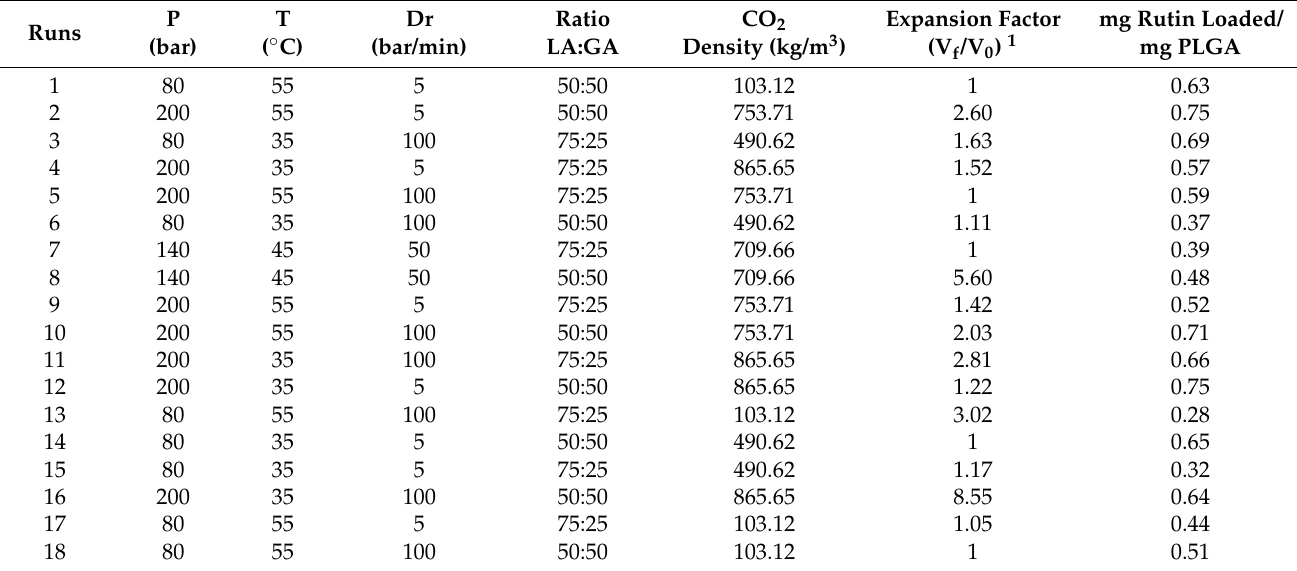
Table 2. Experimental design and observed